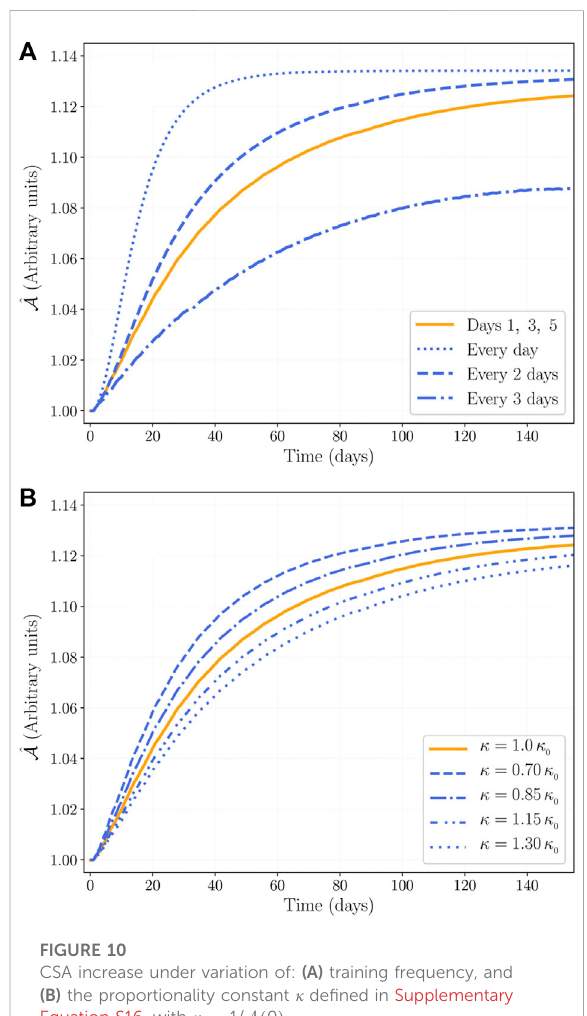
FIGURE 10 CSA increase under variation of: (A) training frequency, and (B) the proportionality constant κ de fi ned in Supplementary Equation S16, with κ 0 (cid:1) 1/ A ( 0 ) .